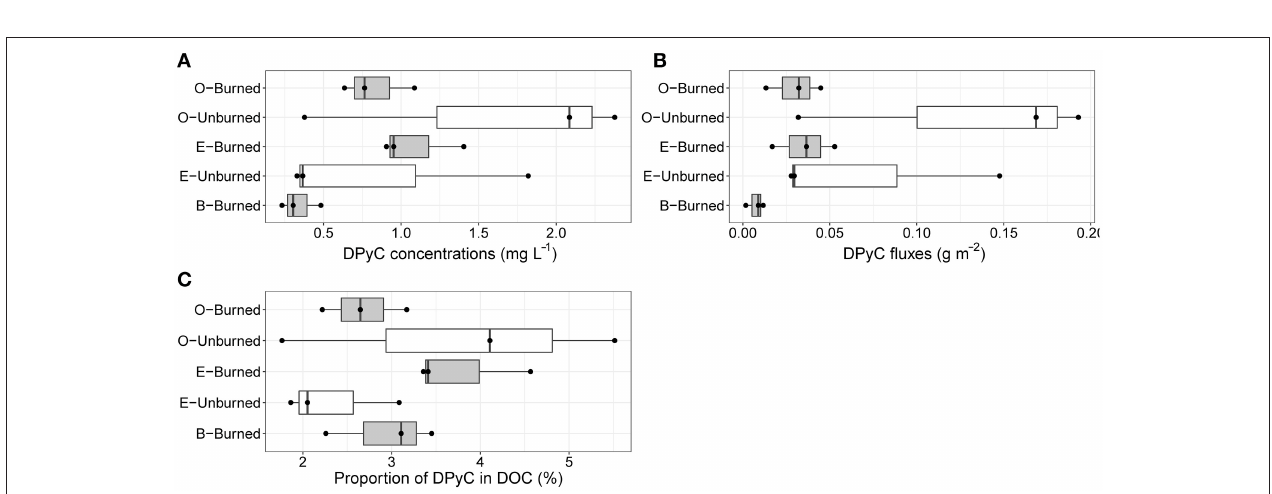
FIGURE 3 | Box-plot of DPyC concentration ( A , mg L − 1 ), flux ( B , g m − 2 ), and proportion of DPyC in total DOC ( C , %) in soil solution drained from the O, E, and B horizons in burned sites and from the O and E horizons in unburned sites. DPyC was determined by the BPCA-DOC method. BPCA-based DPyC data for the B horizon in unburned sites are missing in (A–C) due to lack of replication. Dark circles are individual data points. Statistically significant differences in (A) between E and B horizons in burned sites ( P =